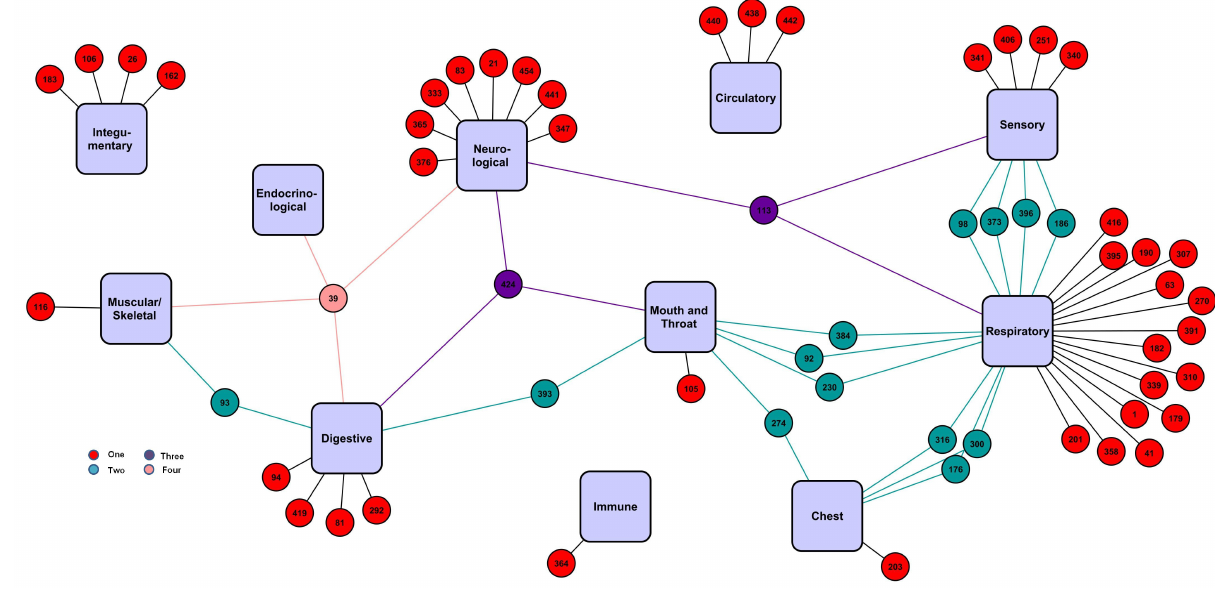
Figure 4. Positive interactome for the Electronic Cigarette